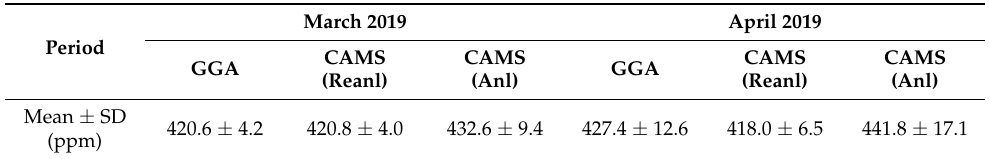
Table 4. Statistical characteristics of the CAMS and observation data for Peterhof in March and April 2019; Reanl: reanalysis; Anl: